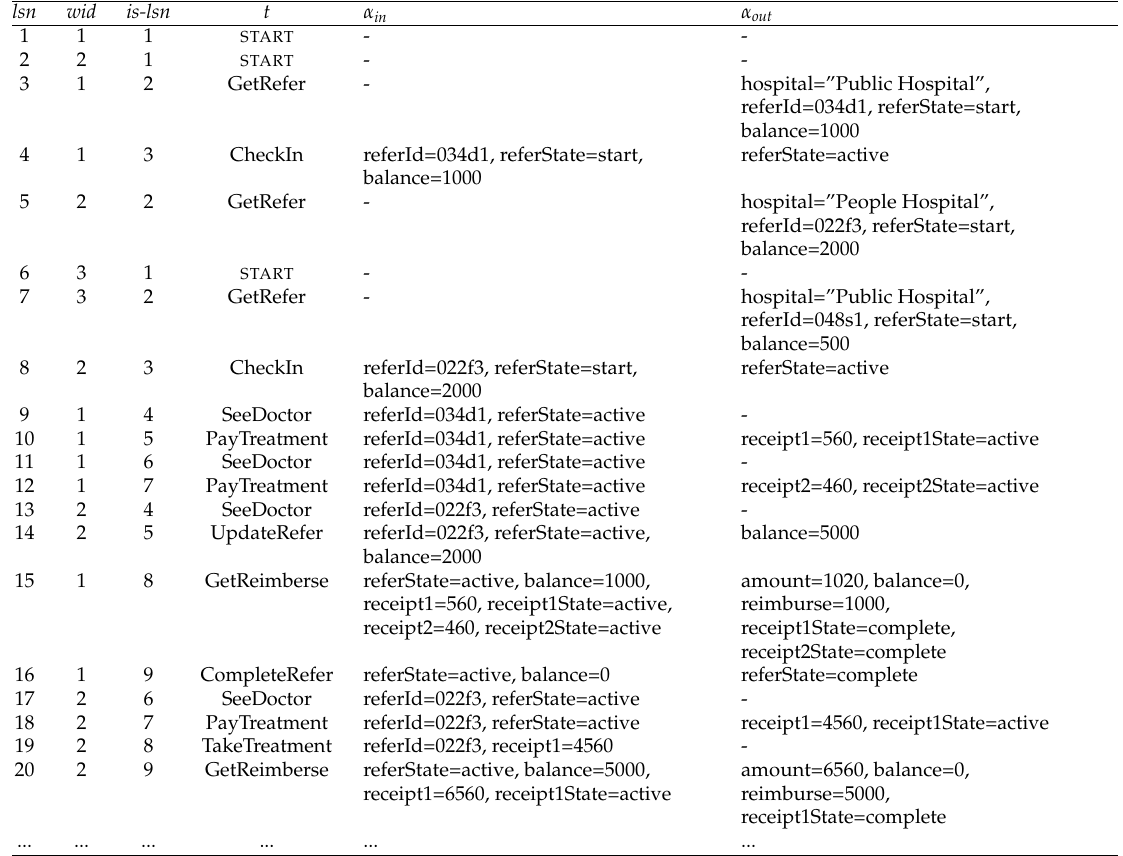
Figure 3. An initial segment of a medical clinic referral